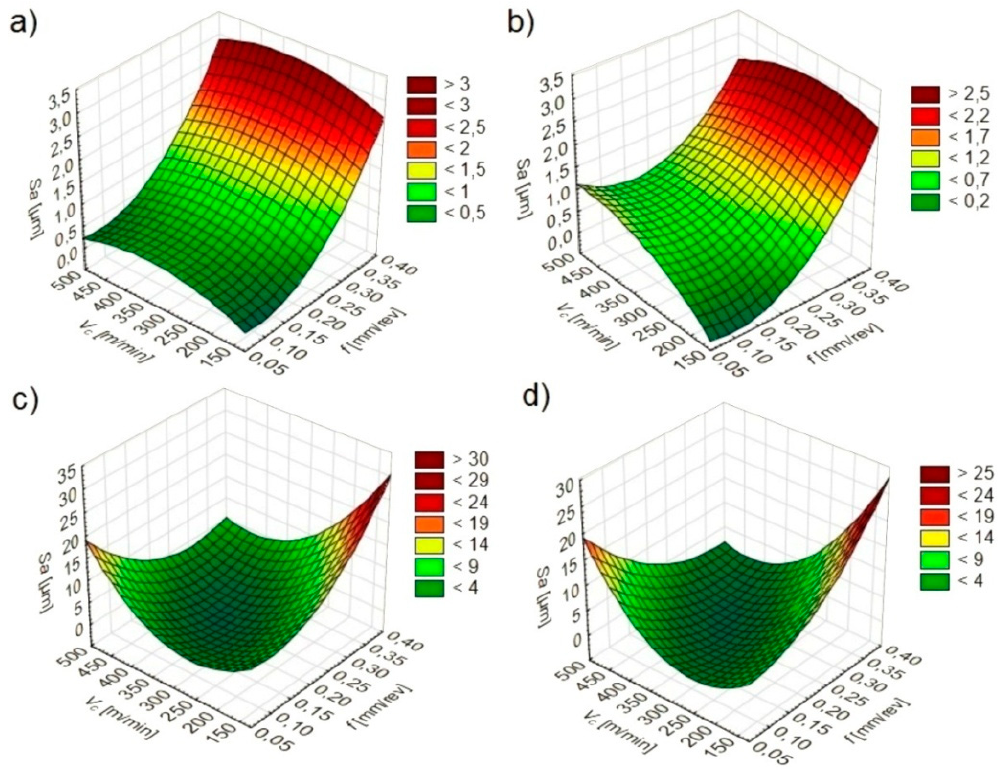
Figure 3. Sa dependence on cutting parameters under: ( a ) dry; ( b ) wet; ( c ) MQL; ( d ) MQL+EP conditions.